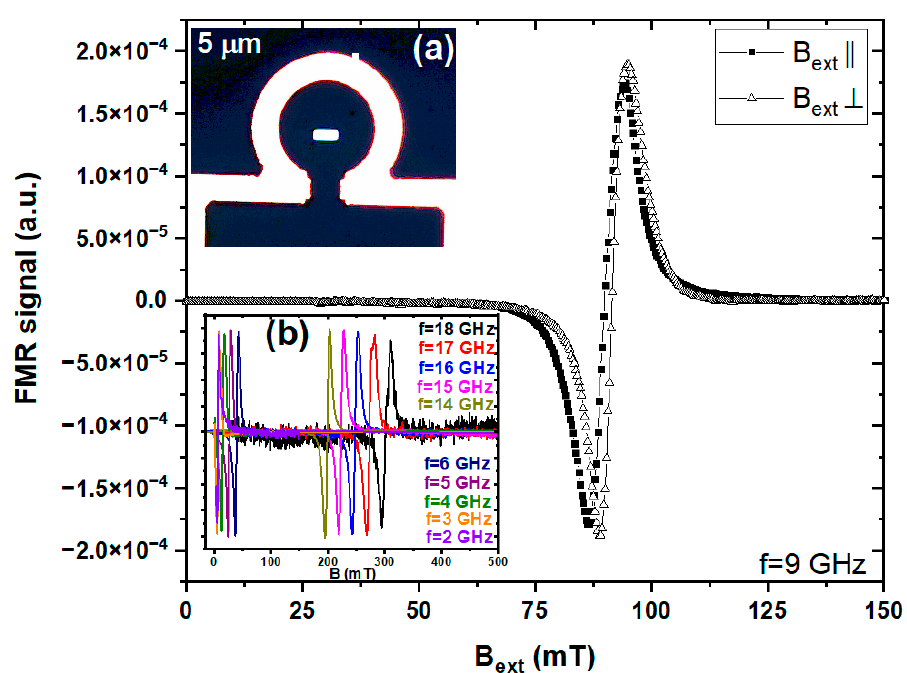
Figure 5. FMR spectra taken at 9 GHz along the hard axis (open triangles) and easy axis (solid squares). ( a ) The inset shows the optical microscopy image of the Py strip inside the microantenna loop. ( b ) FMR spectra measured at the lower and upper limit of the frequency range of the µ-FMR setup.